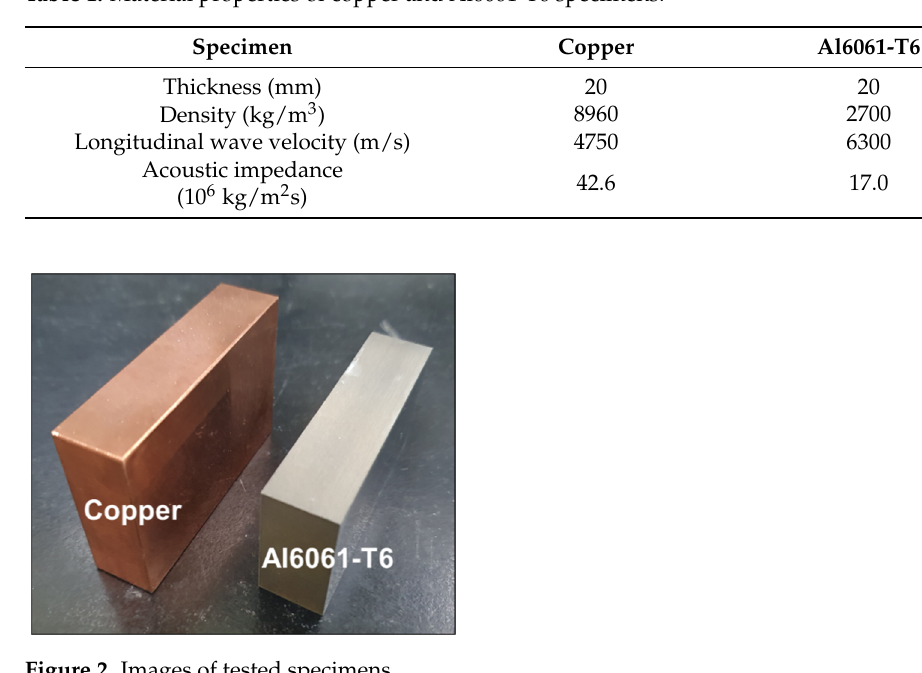
Figure 1. Schematic configuration of photorefractive interferometric system.